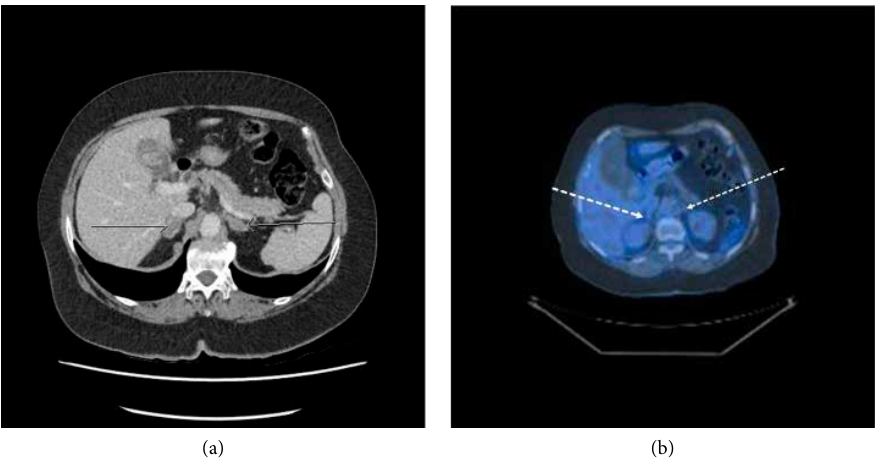
Figure 4: (a) Axial noncontrast CT image following six cycles of primary chemotherapy demonstrating good response with both adrenal metastases decreased in size (white arrows). (b) The adrenal metastases were no longer